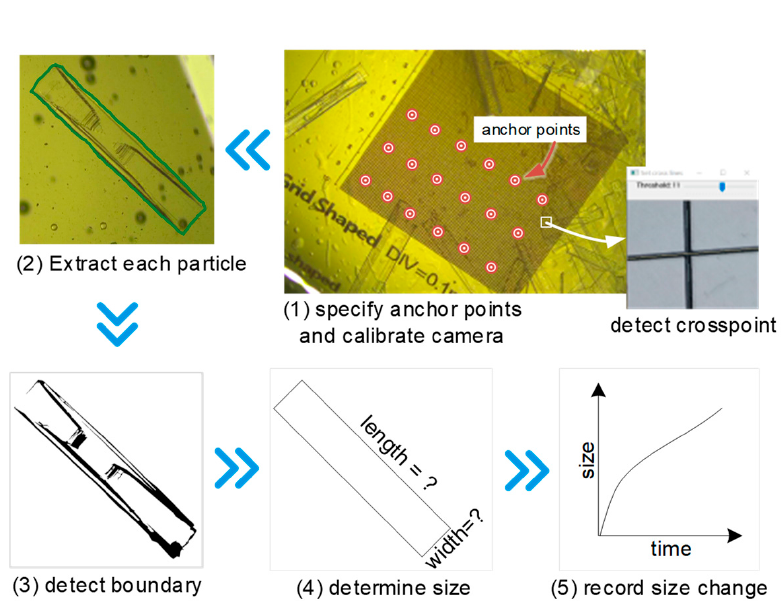
Figure 4. The procedure of crystal growth rate measurement.